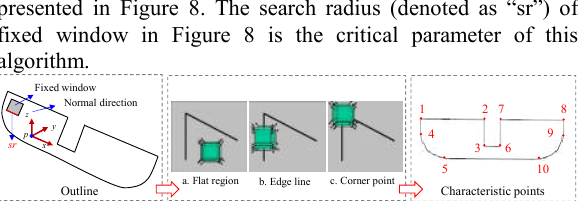
Figure 8. Schematic diagram of the characteristic point detection algorithm.